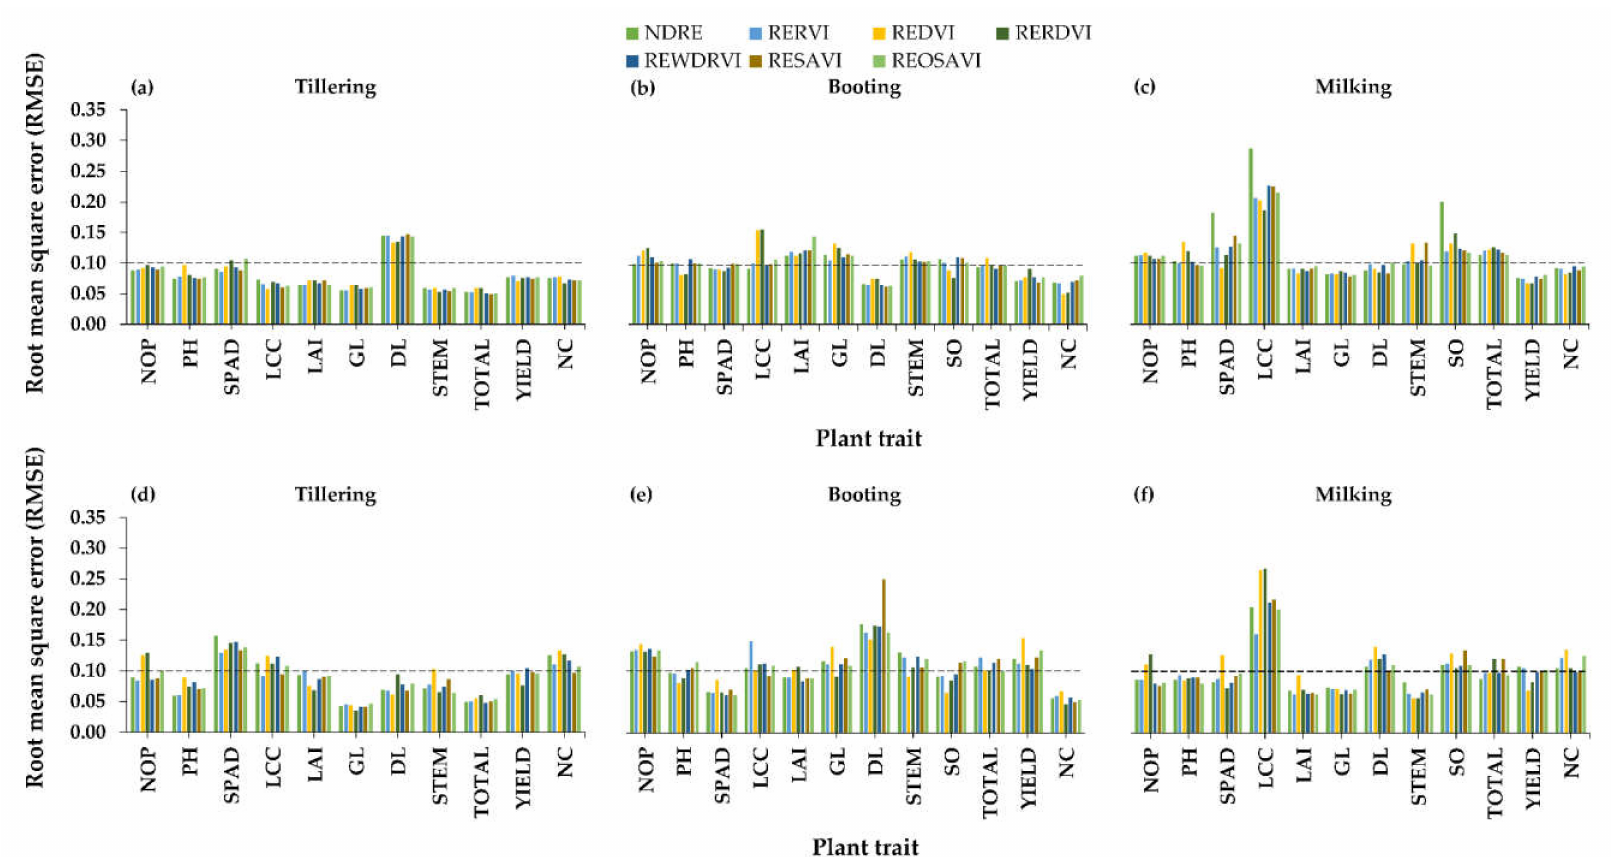
Figure 7. RMSE values for the red-edge-NIR indices’ training ( a – c ) and testing ( d – f ) models for all plant traits at different rice growth